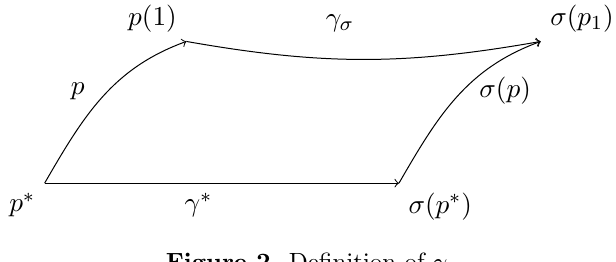
Figure 2 . De(cid:12)nition of (cid:13) (cid:27)